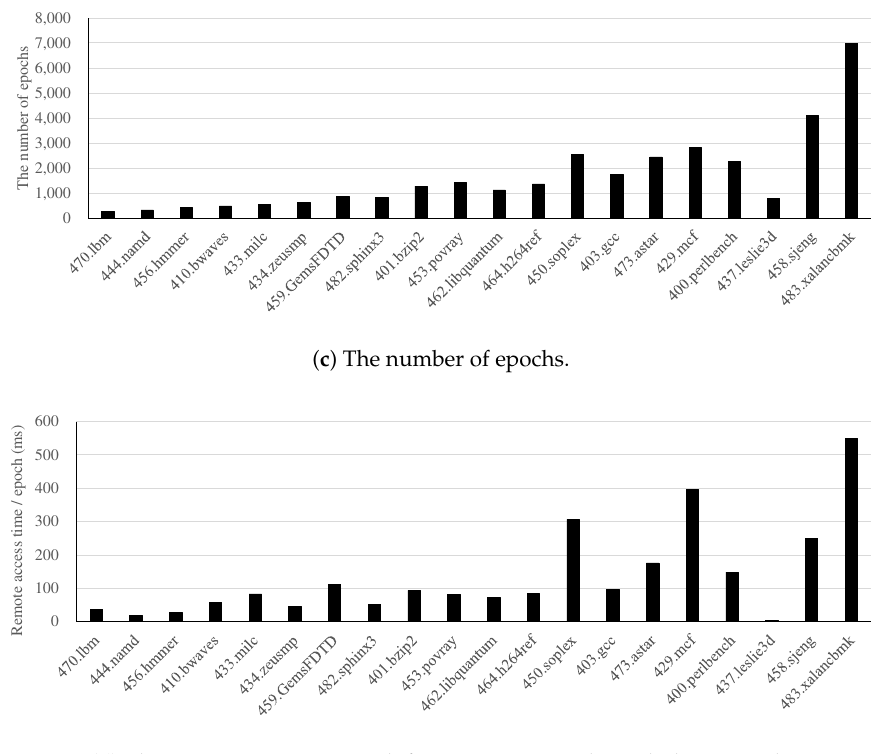
( d ) The average time per epoch for remote access through the network. Figure 9. Results of Hadoop-based microarchitecture simulation on the SPEC CPU2006